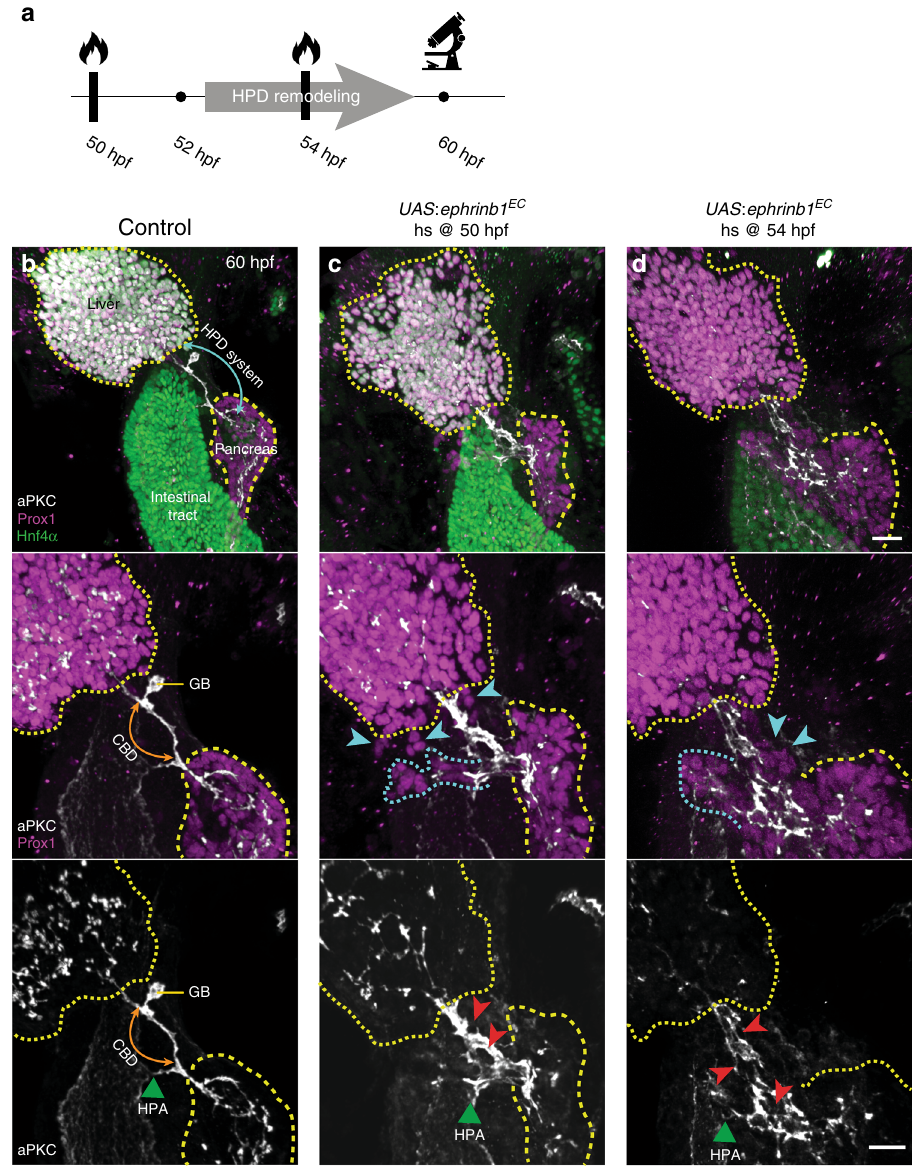
Fig. 5 EphB/EphrinB signaling controls HPD lumen morphogenesis independently of other morphogenetic roles. a Conditional ephrinb1 EC expression is induced by heat-shock prior to or during CBD remodeling, at 50 hpf or 54 hpf, respectively. Embryos were analysed at 60 hpf (heat-shock at 50 hpf: n = 7, heat-shock at 54 hpf: n = 7, both N = 1). b – d Hnf4 α (green), Prox1 (magenta) and aPKC (gray) labeling show that unlike in controls ( b ), conditional ephrinb1 EC expression at 50 hpf ( c ) and 54 hpf ( d ) leads to HPD, liver and pancreas morphology defects, ectopic Prox1-positive cells throughout the HPD (blue arrowheads), with a subset associated with ectopic lumina bifurcating from the main duct (outlined with blue dashed line) disrupted and disorganized HPD lumen (red arrowheads, c , d ). Yellow dotted lines: liver, yellow dashed line: pancreas; blue arrow: HPD system, orange arrow: CBD, green arrowhead: